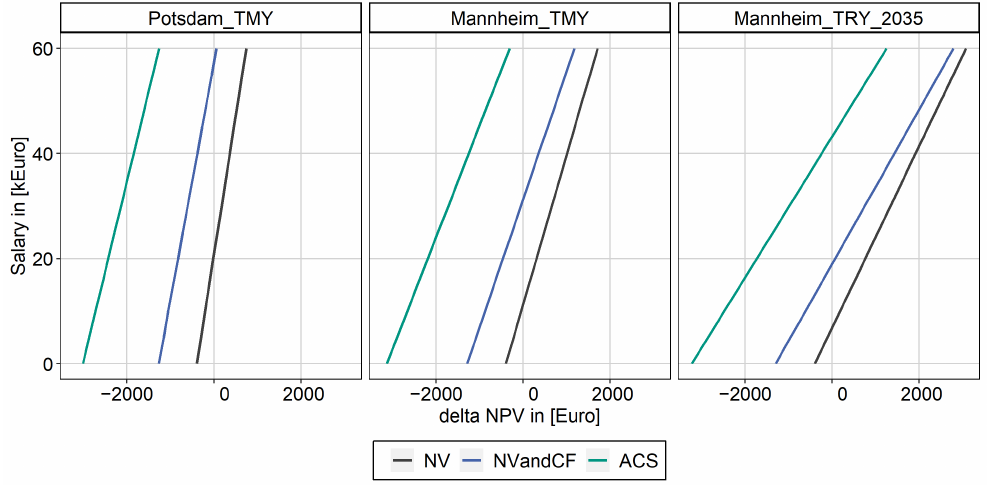
Figure 9. ∆ NPV sensitivity to salary